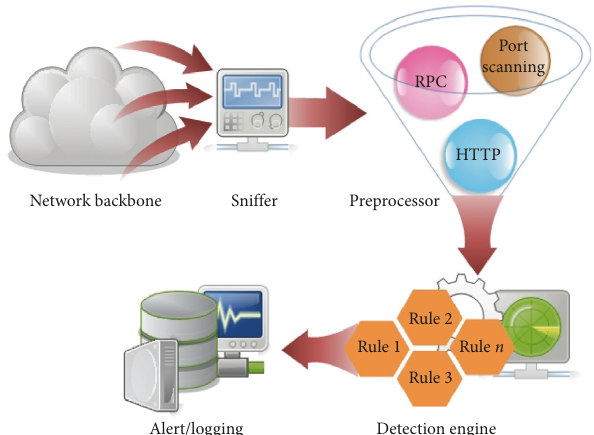
Figure 3: General architecture of